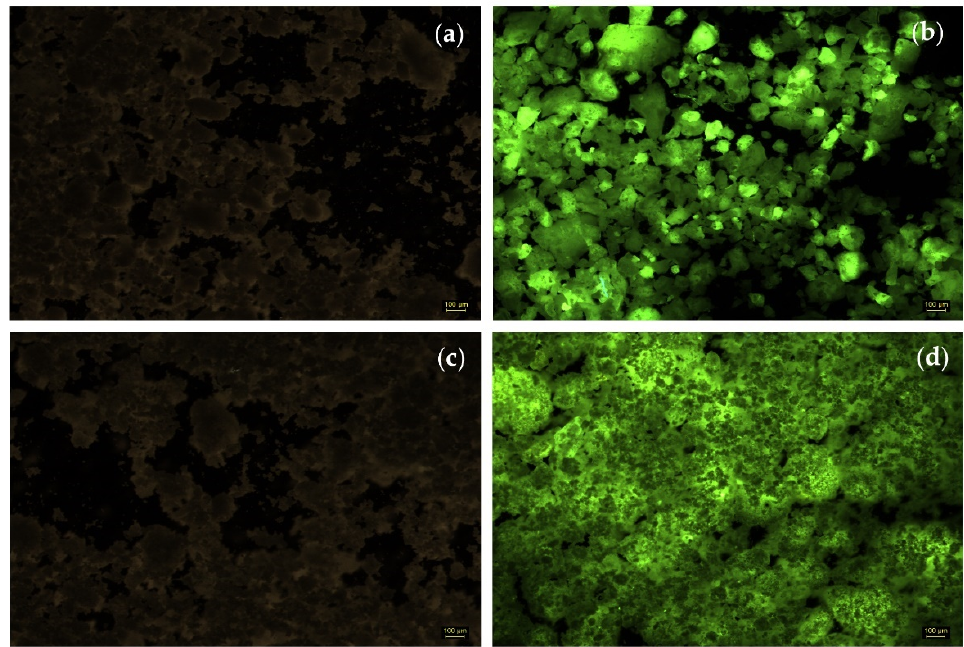
Figure 5. Fluorescent images of blank sol–gel matrices (without enzymes) and the sol–gel matrices